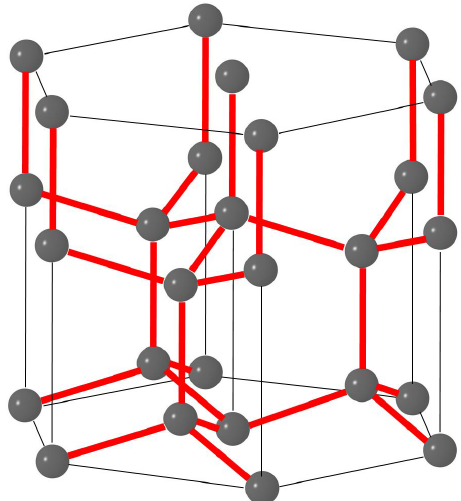
Figure 2. The hexagonal elementary crystal of ice Ih (Penny, 1948; Schulson, 1999) consists of 27 oxygen (O) atoms (spheres) and 28 hydrogen (H) bonds between them (bars). Of the four H atoms ad- jacent to each O atom, two are placed closer than the other pair, thus retaining the structure of individual H 2 O molecules within the crystal lattice. Despite the crystal’s anisotropy, thermodynamic ice properties are isotropic to within measurement